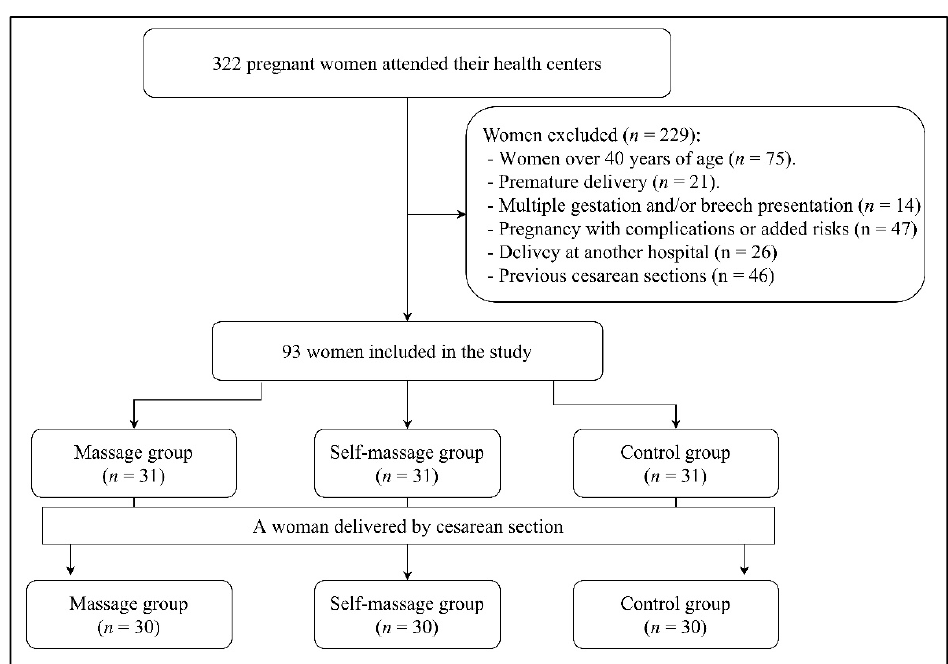
Figure 1. CONSORT flow diagram.